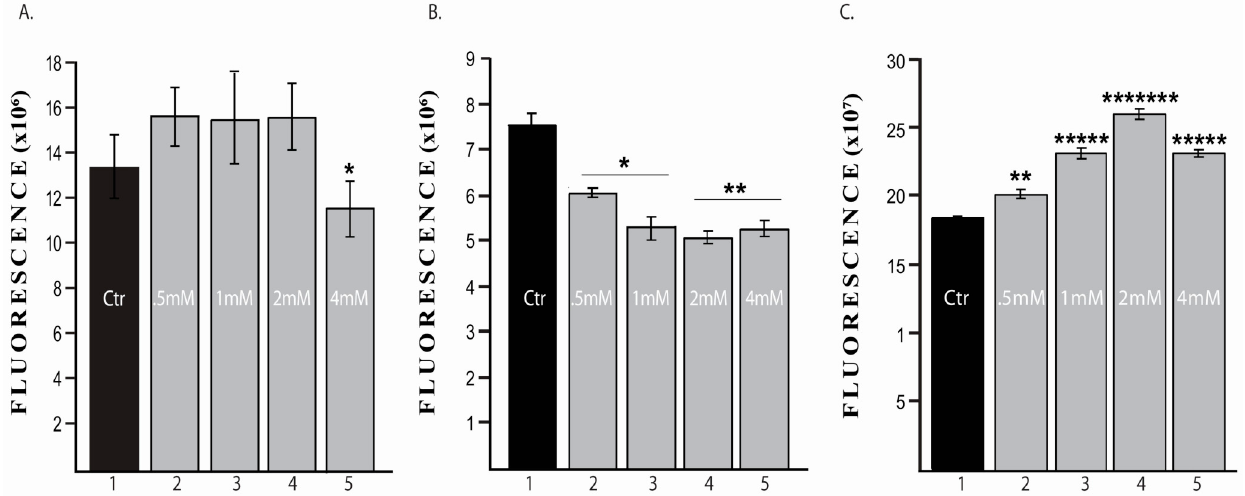
Figure 1. Cell viability. ( A ) Normal mammary epithelial cells MCF10a; ( B ) human breast adenocarcinoma cell line MDA-MB 231 at 24 h; ( C ) human breast adenocarcinoma cell line MDA-MB 231 at 72 h; (1. Untreated; 2–5 treated with 0.5 mM, 1 mM, 2 mM, and 4 mM sevoflurane), * p < 0.05; ** p < 0.005; ***** p < 0.000005; ******* p < 0.00000005. n = 3 (8 wells per group).